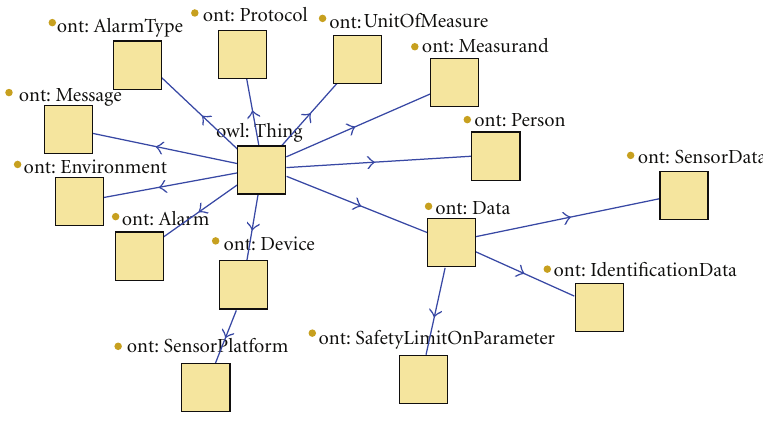
Figure 3: Ontology class